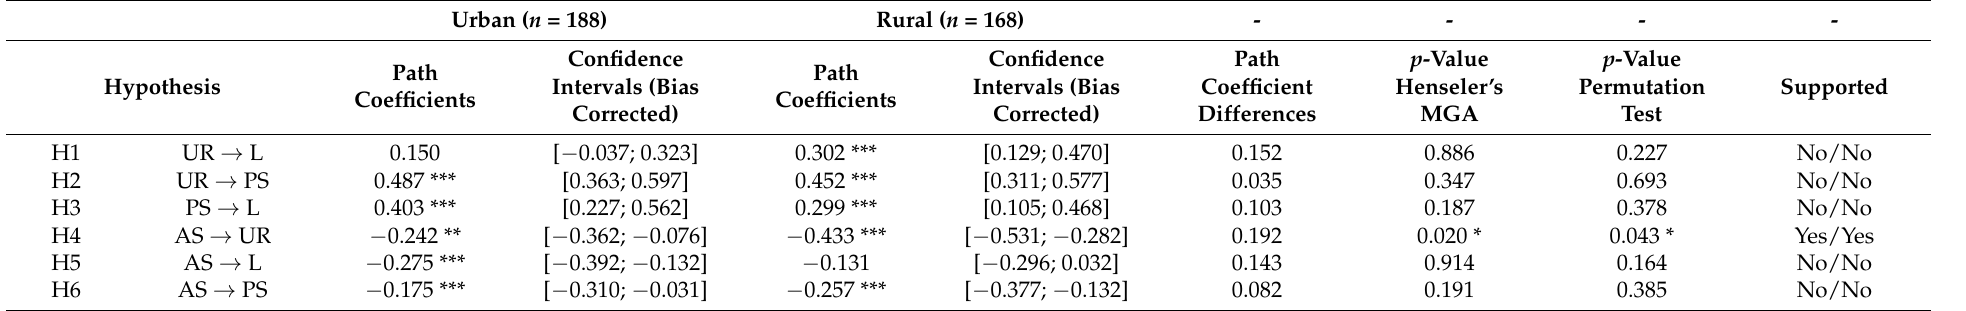
Table 6. Results of MGA between urban and rural young